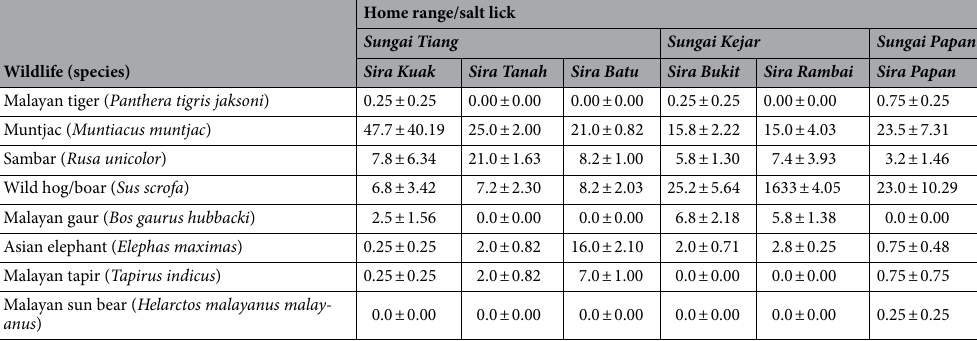
Table 1. The number of sightings of different species at the salt licks in the Royal Belum Rainforest (mean ± SD).